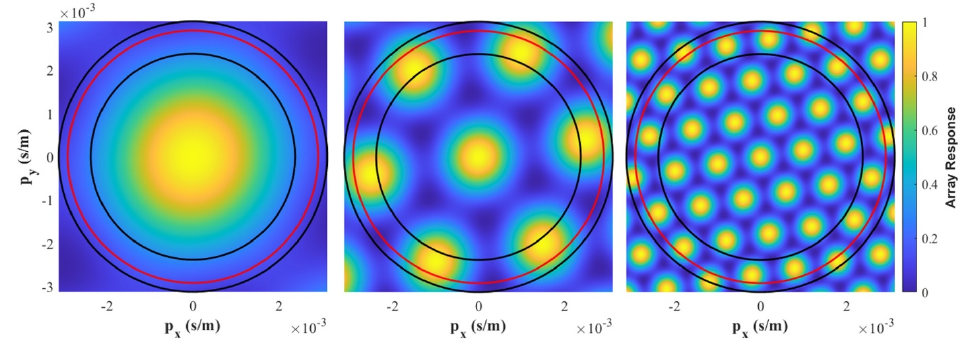
Figure 3. Beamforming array response for OSU1 at ( left ) 3 Hz, ( middle ) 8 Hz, and ( right ) 20 Hz. The three concentric circles correspond to 420, 343, and 320 m/s (from the inner to the outer circle).